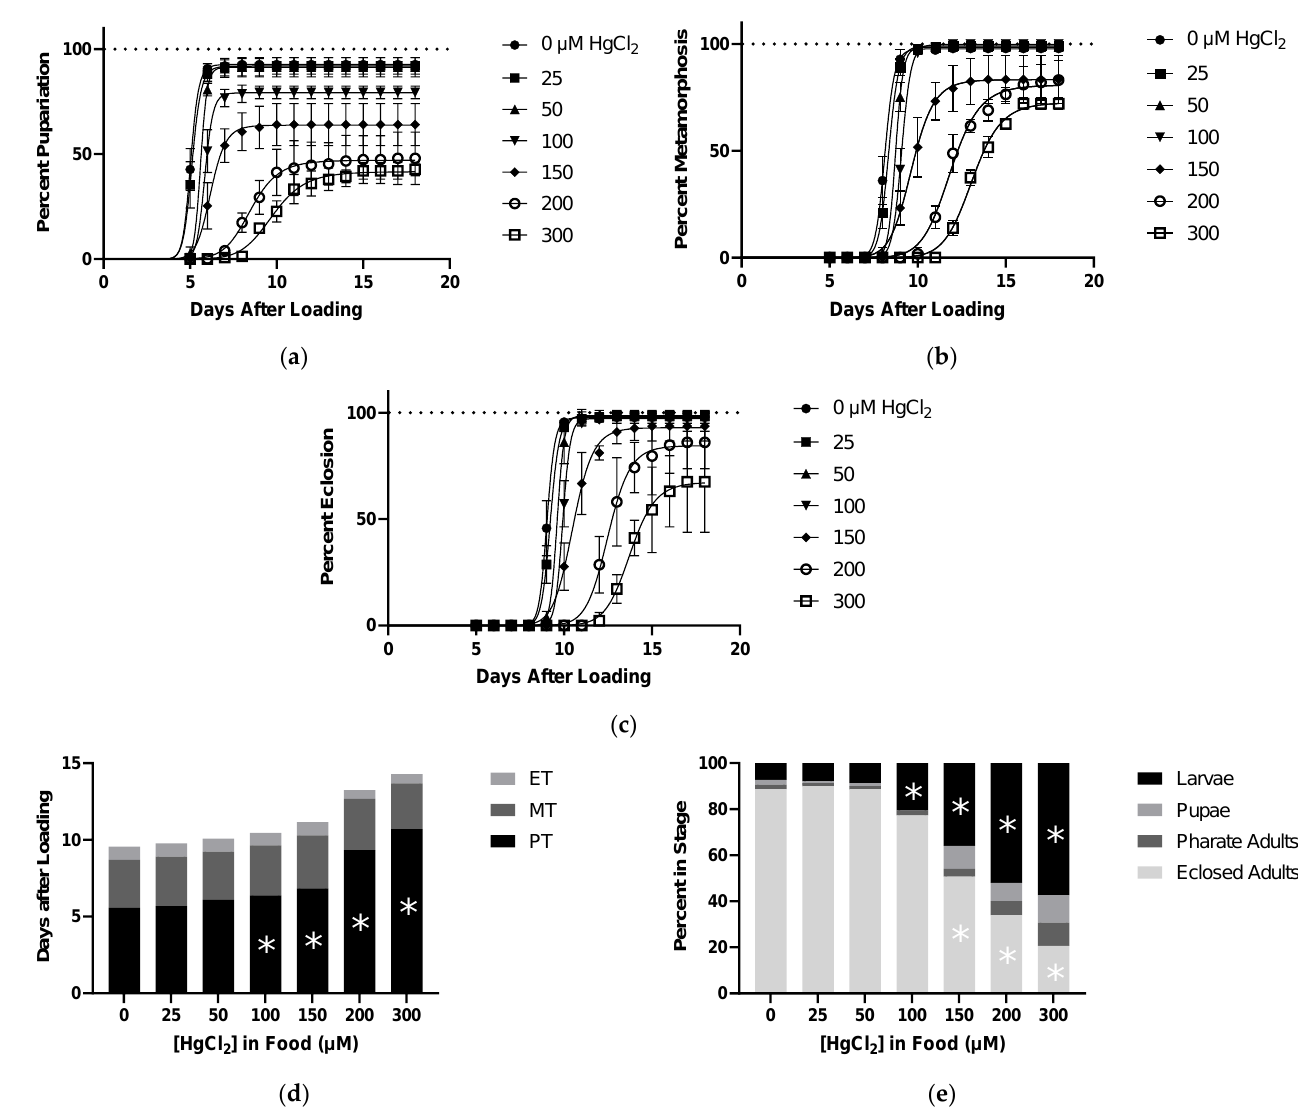
Figure 2. Effects of HgCl 2 on Developmental Time Course. All data from same experiment using CS larvae dosed with indicated concentrations of HgCl 2 in food. ( a ) Pupariation: pupae formation rates of larvae after being loaded onto food. ( b ) Pupa Metamorphosis: pharate adult formation rates of pupae standardized to total pupae formed. ( c ) Pharate Adult Eclosion: rate of eclosion standardized to total number of individuals completing metamorphosis. ( d ) Developmental Timing: representation of time spent in each stage derived from data shown in Figure 1a – c. This allows for accounting of delays seen in later stages caused by carryover of pupariation delays. ( e ) Developmental Endpoints: representation of individuals in each stage at the defined endpoint of 18 days from 1a – c. Individuals that are not eclosed adults correspond to a lethality during development. (* p < 0.05 compared to 0 µM, two-way ANOVA).